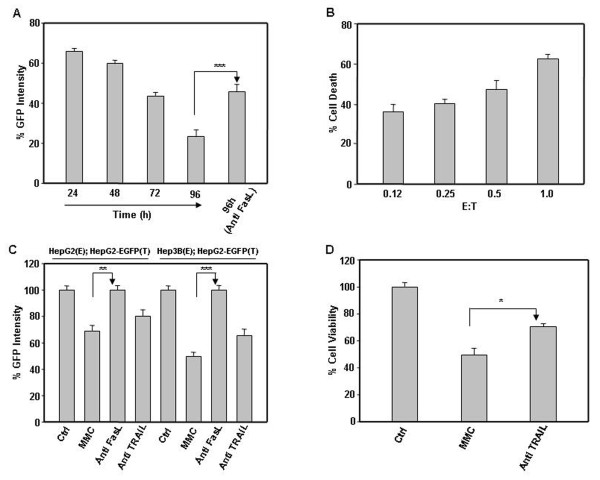
Medium transfer experiments to detect the presence of soluble cytotoxic effector molecules. (A) Time-course release of cytotoxic factor from MMC treated effector HepG2 cells. The effector cells were treated with MMC for 24 h and fresh medium was added as described in materials and methods. At the time indicated, corresponding supernatants were collected and added to the untreated target HepG2-EGFP cells with or without neutralizing anti-FasL antibody. Target cells were incubated with the supernatants for 48 h before quantitating fluorescence. The supernatants were supplemented with 0.2% FBS to avoid cell death due to growth factor depletion. The culture supernatant from untreated HepG2 cells was used as control and fluorescent intensity was calculated with respect to identical time point controls. (B) The target cell death increases with the increase in number of effector cells. Effector cells were treated with MMC for 24 h and fresh medium was added as described in materials and methods. The supernatants were collected after 48 h and used to culture target HepG2-EGFP cells for 48 h before quantitating fluorescence. (C) Involvement of death ligands in bystander killing of hepatoma cells. Bystander killing of HepG2-EGFP cells is mediated by FasL. Effector HepG2 and Hep3B cells were treated with MMC (150 nM) and target HepG2-EGFP cells were co-plated with or without neutralizing antibody against FasL (1 μg/ml) and TRAIL (2 μg/ml). (D) Bystander killing of target Hep3B cells by effector Hep3B cells treated with MMC (150 nM) is mediated by TRAIL. Trypan blue assay to detect the percentage cell viability in co-cultures of effector and target Hep3B cells in the presence of neutralizing anti-TRAIL antibody. After 72 h of growth in co-culture cells were harvested by trypsinization and stained with 0.005% trypan blue for 5 min at RT. Unstained as well as stained cells were counted in haemocytometer and percentage cell viability was calculated. Data presented are representative of three independent experiments performed in triplicates and expressed as mean ± s.d. *, ** and *** differs significantly at p < 0.05.